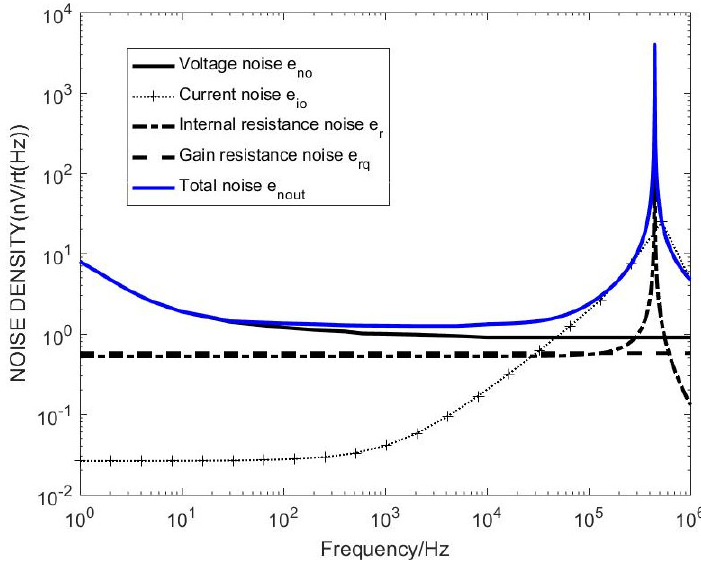
Figure 9. Noise distribution map without matching resistance sensor.